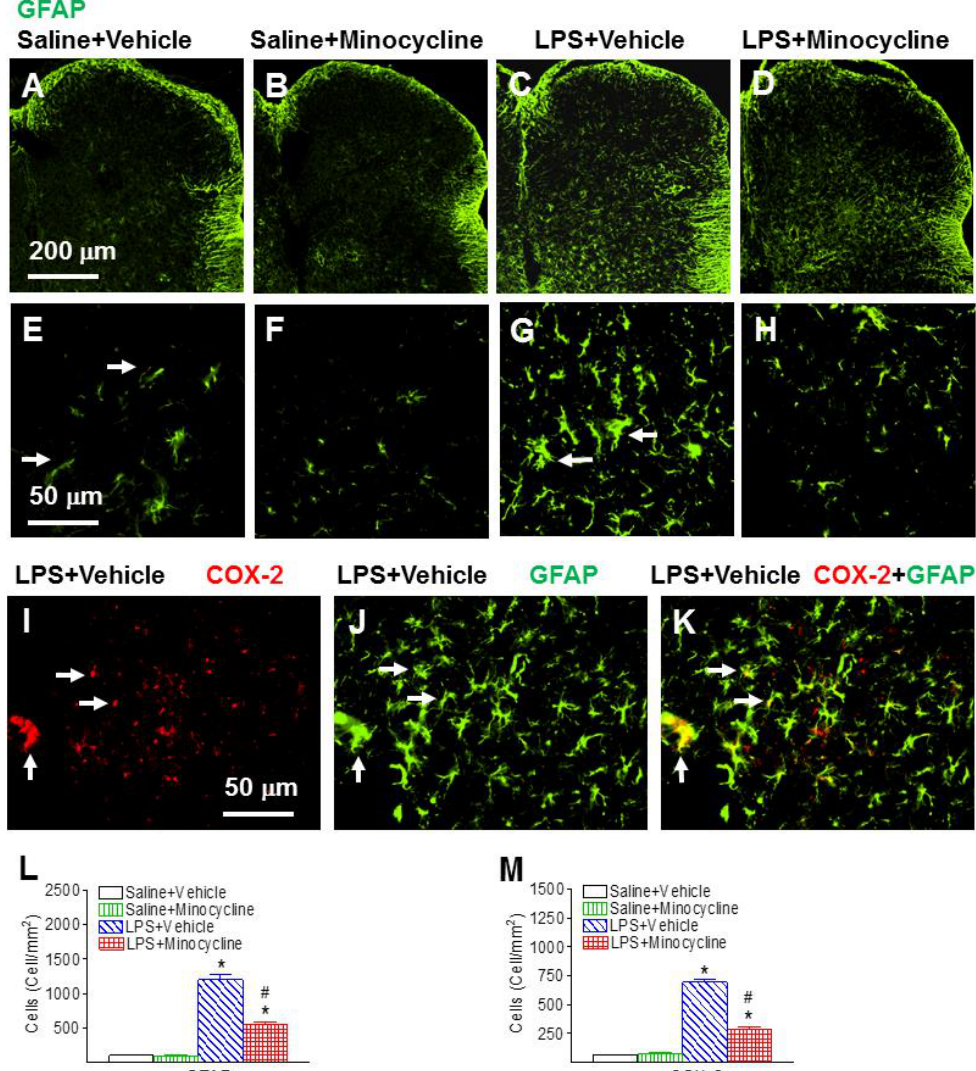
Figure 5. Minocycline reduced neonatal LPS-induced astrocyte activation, as assessed by glial fibrillary acidic protein (GFAP+) staining in the spinal dorsal horn of the P6 rats. Representative photomicrographs of GFAP immunostaining ( A – H ) in the rat spinal cord 24 h (P6) after LPS injection. Most of the astrocytes were in a resting state with fine processes extending from the main cellular processes (arrows indicated in ( E )) in the rat spinal dorsal horn of the Saline + Vehicle group ( A , E ). LPS exposure induced the increase of numerous activated astrocytes with the hypertrophy of cellular processes (( C , G ), arrows indicated in ( G )). Minocycline attenuated an LPS-induced increase in